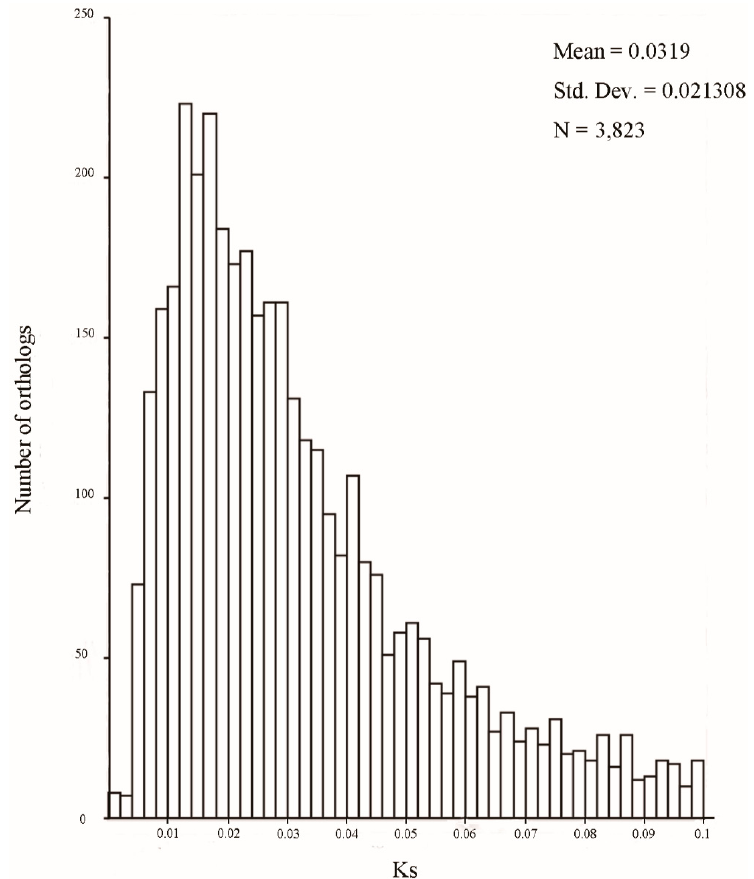
Figure 3. The Ks distribution of orthologs between Notopterygium incisum and Notopterygium franchetii ; their divergence is shown by the peak of Ks at 0.011 ± 0.021.